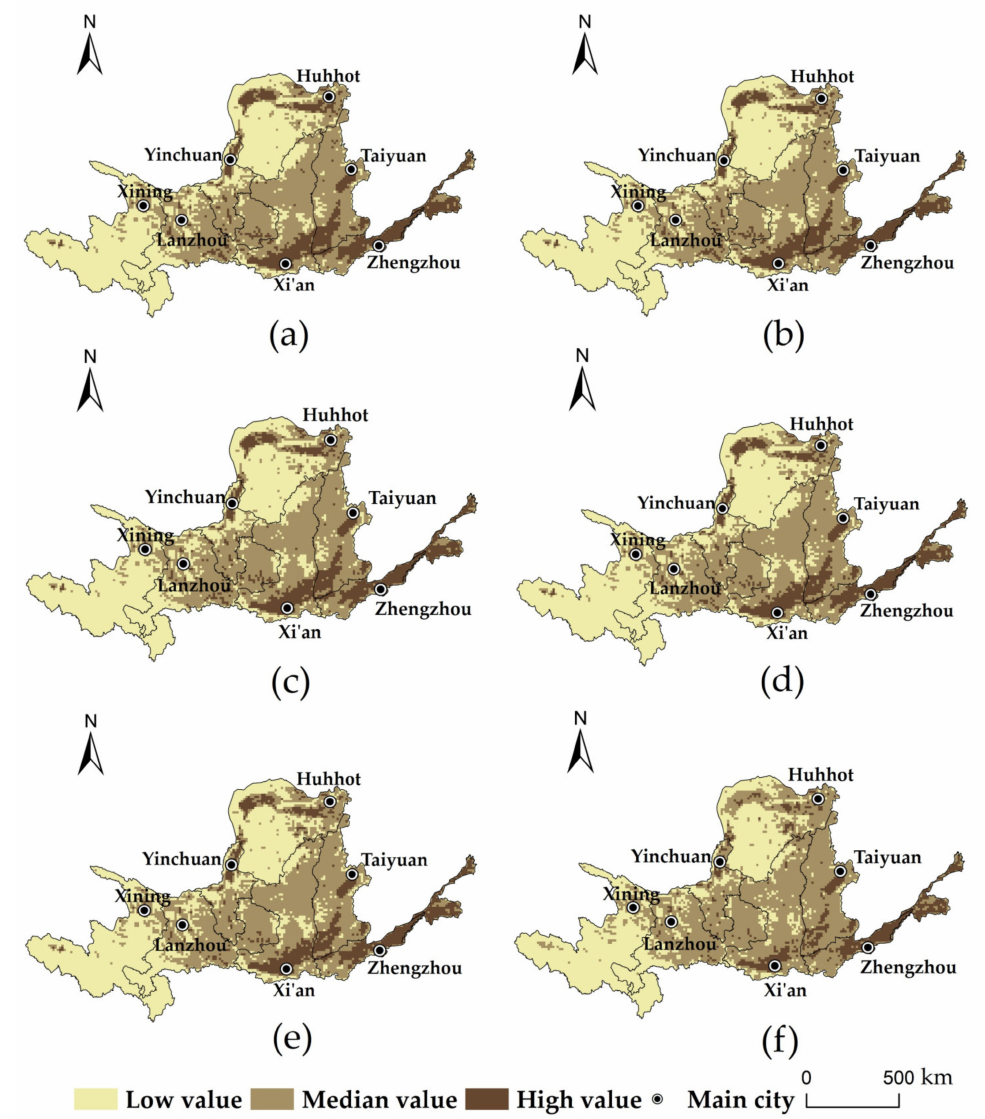
Figure 4. Spatial distribution of comprehensive benefits of land use in the Yellow River Basin: ( a ) 1995; ( b ) 2000; ( c ) 2005; ( d ) 2010; ( e ) 2015; ( f ) 2018. Low economic benefit areas were widely distributed in the west and north-central part of the basin (Figure 5). The high-value areas were concentrated in the northern edge and in the four provinces of Shandong, Henan, Shaanxi, and Shanxi of the southeast. The middle-value areas were concentrated in the middle of the basin. The distribution characteristics of social benefits were basically consistent with comprehensive benefits and economic benefits (Figure 6). The ecological benefits were basically in the median value areas (Figure 7). The high-value areas gathered in the southeast, and the low-value areas were mainly distributed in the eastern downstream area and in the middle and north of the loess plateau area with serious soil